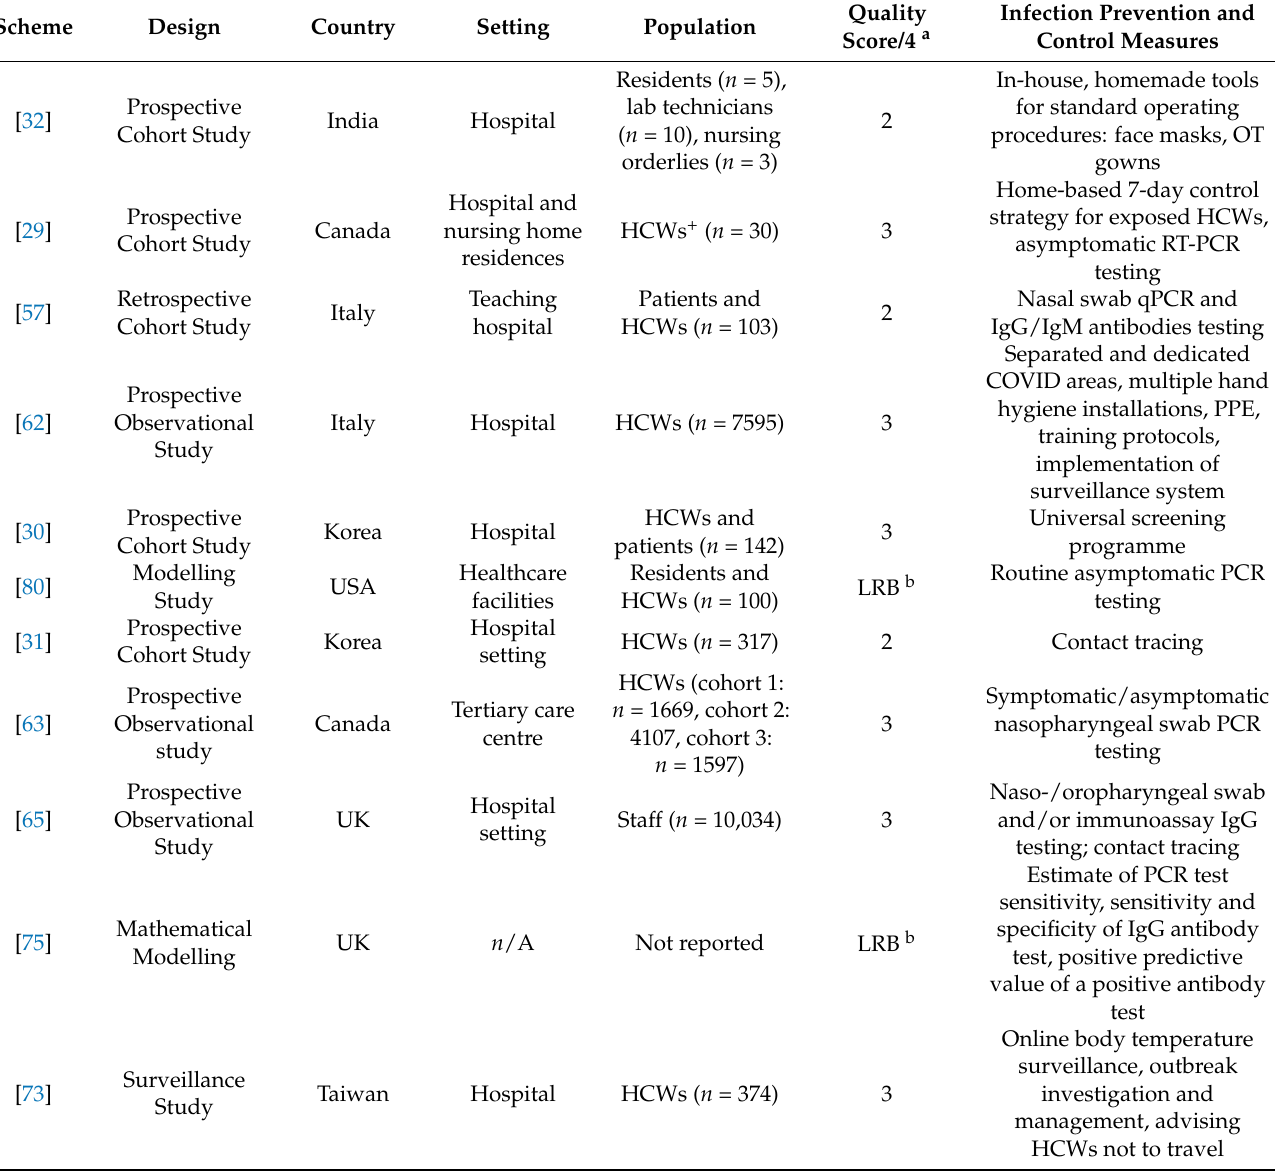
Table 1. Study characteristics and COVID-19 IPC measures implemented in hospital and other healthcare